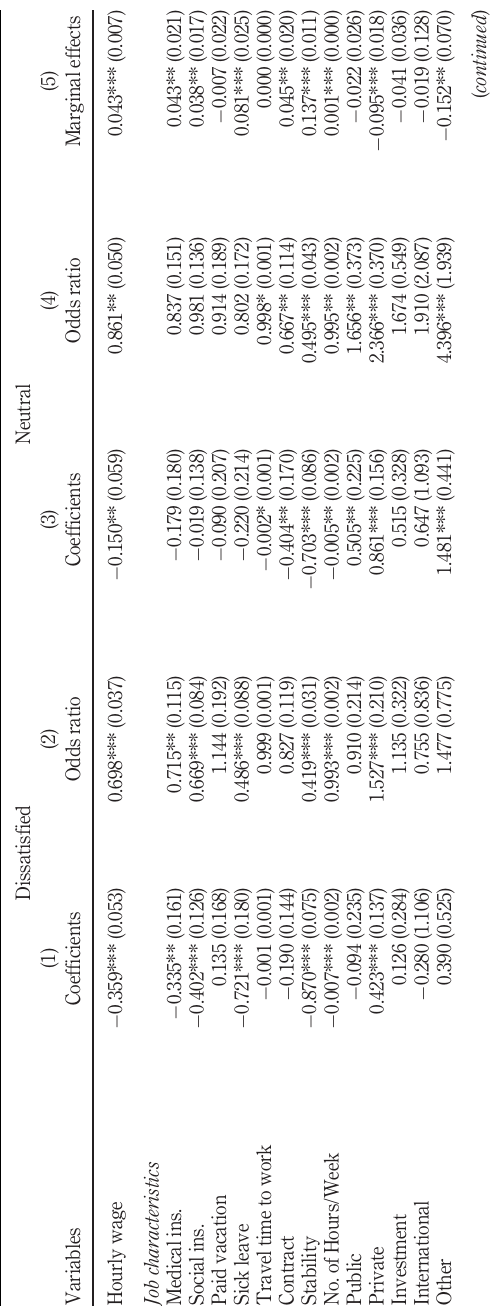
Table AVII. Multinomial logit estimation results for determinants of job